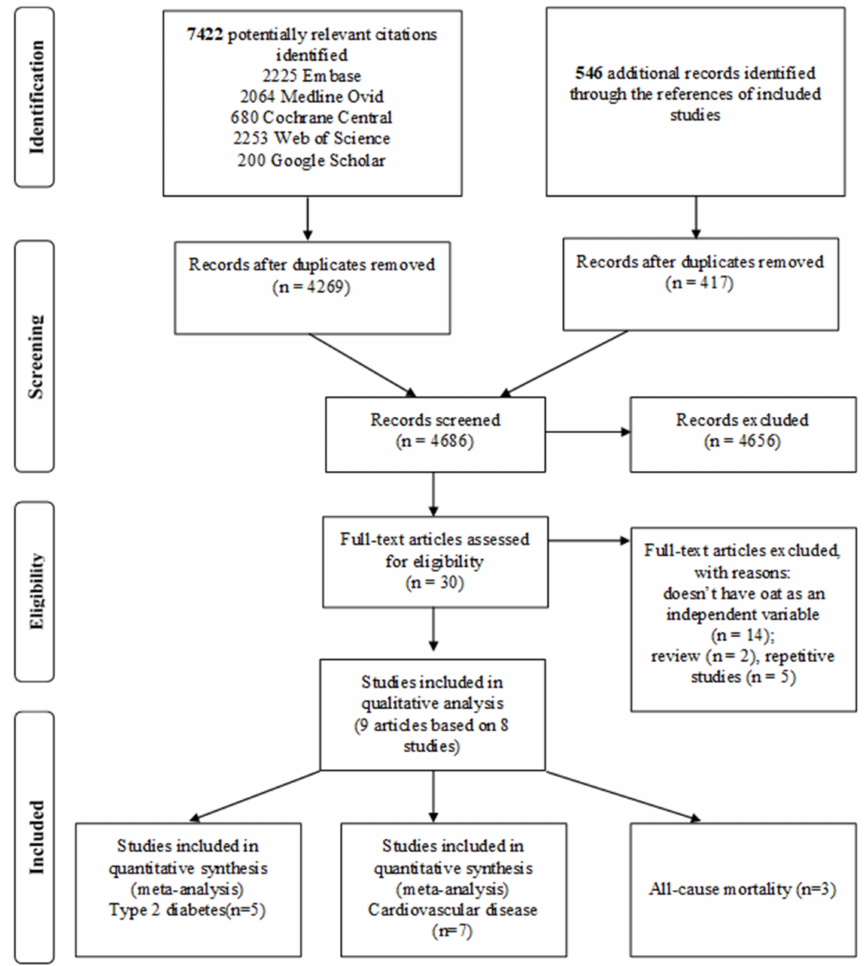
Figure 1. PRISMA flow diagram of search